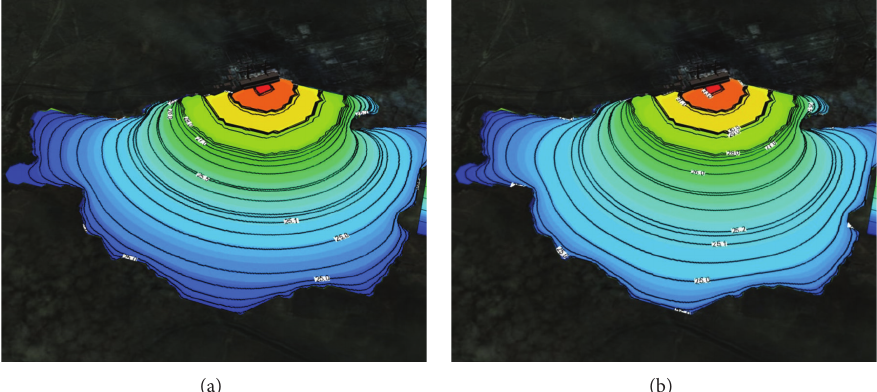
Figure 1: Outline and contours of temperature at 15 and 24 hours after launch of Ekibastuz SDPP-1 on the surface and the side view.